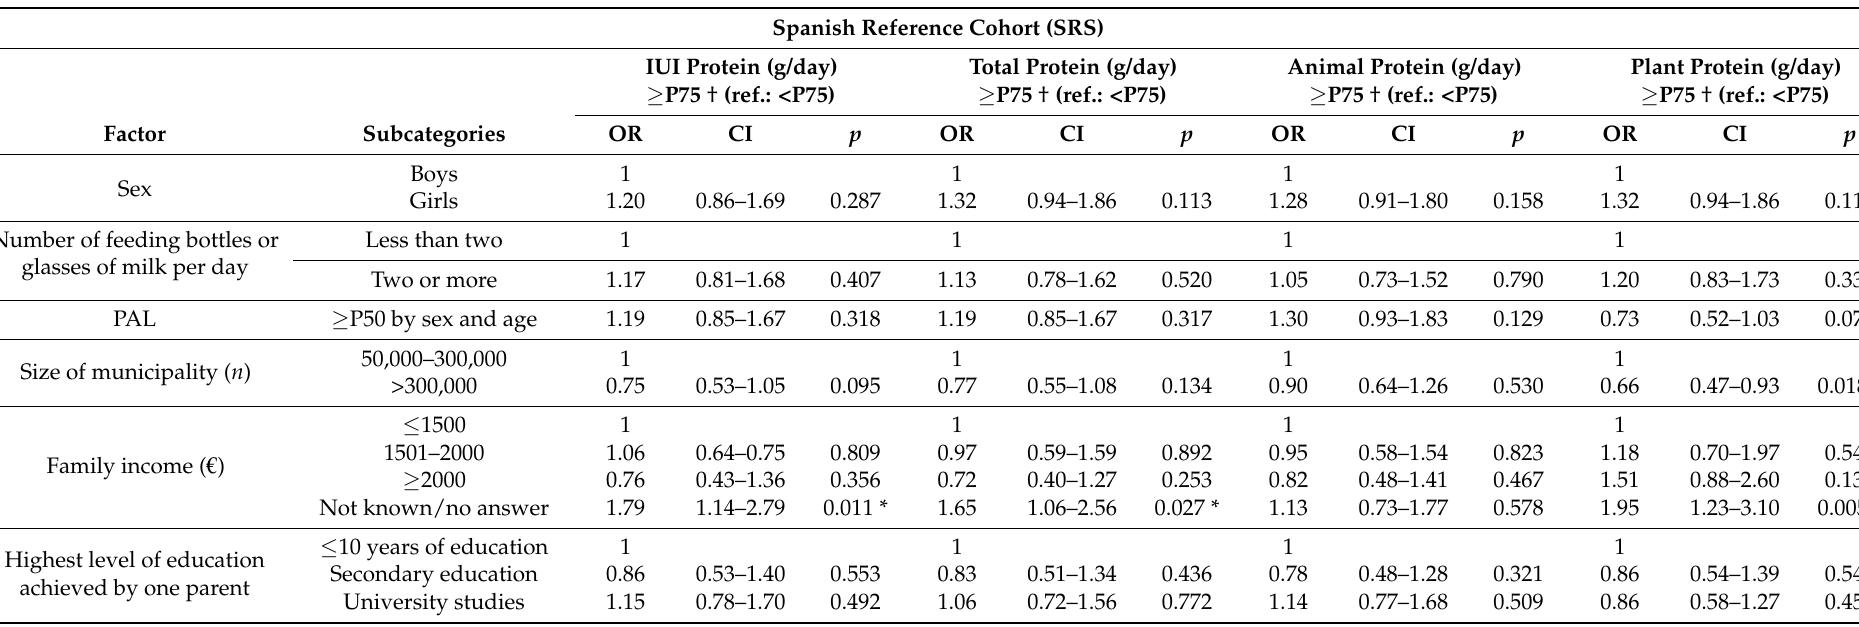
Table 7. Odds ratios and 95% confidence intervals for intake equal to or higher than the 75th percentile (P75) for total protein IUI, total protein, and animal and plant protein relative to family and personal factors in the reference cohort of the Nutritional Study in the Spanish Pediatric Population (EsNuPI) ( n =